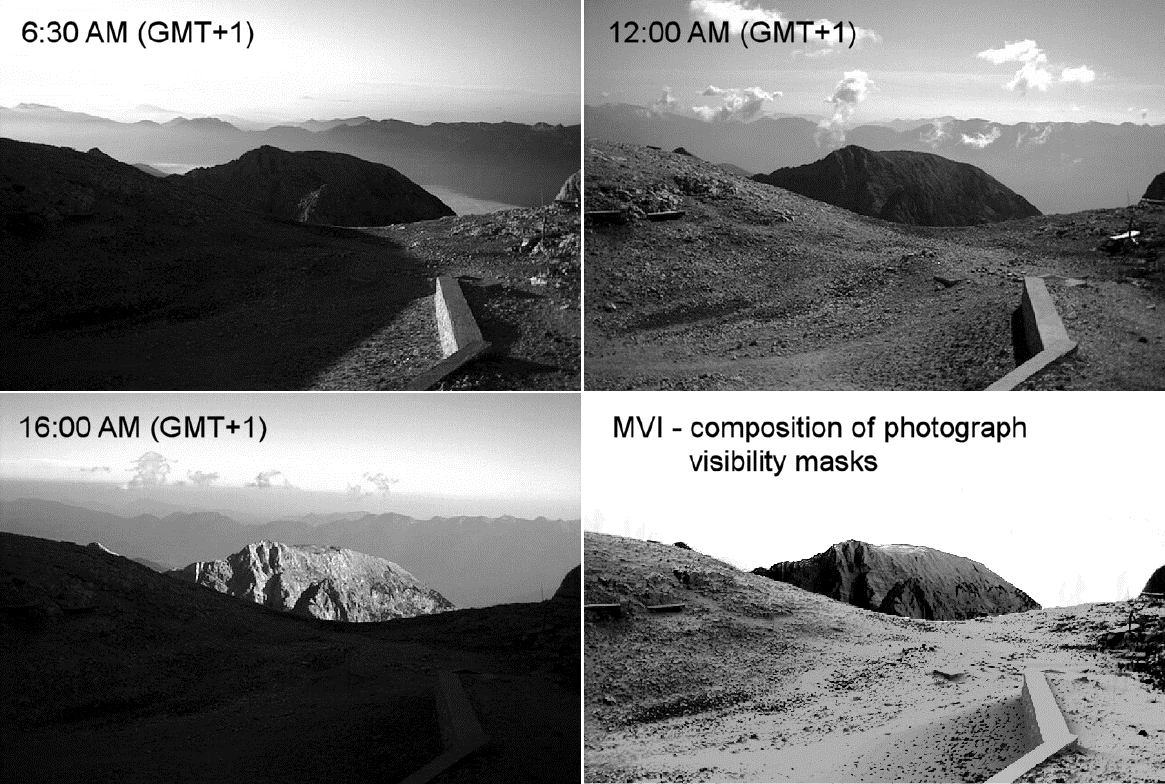
Figure 1. Peaks at different times of day, in different weather, and differently illuminated. An image processing technique of multidirectional visibility index (MVI) [8] shows another aspect in appearance of peaks and other terrain features (a composition of series of 57 photograph visibility masks between 6:30 AM and 17:15 PM (GMT+1), 26 September; view from Kredarica to peak Tosc; webcam of